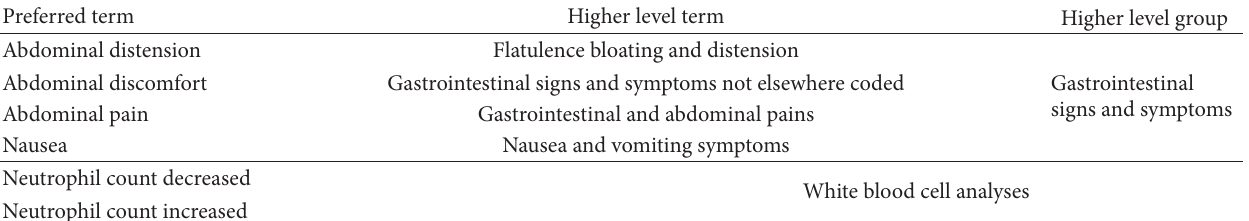
Table 1: Examples of hierarchy of selected medDRA terms used to describe AEFIs in BIOVACSAFE clinical